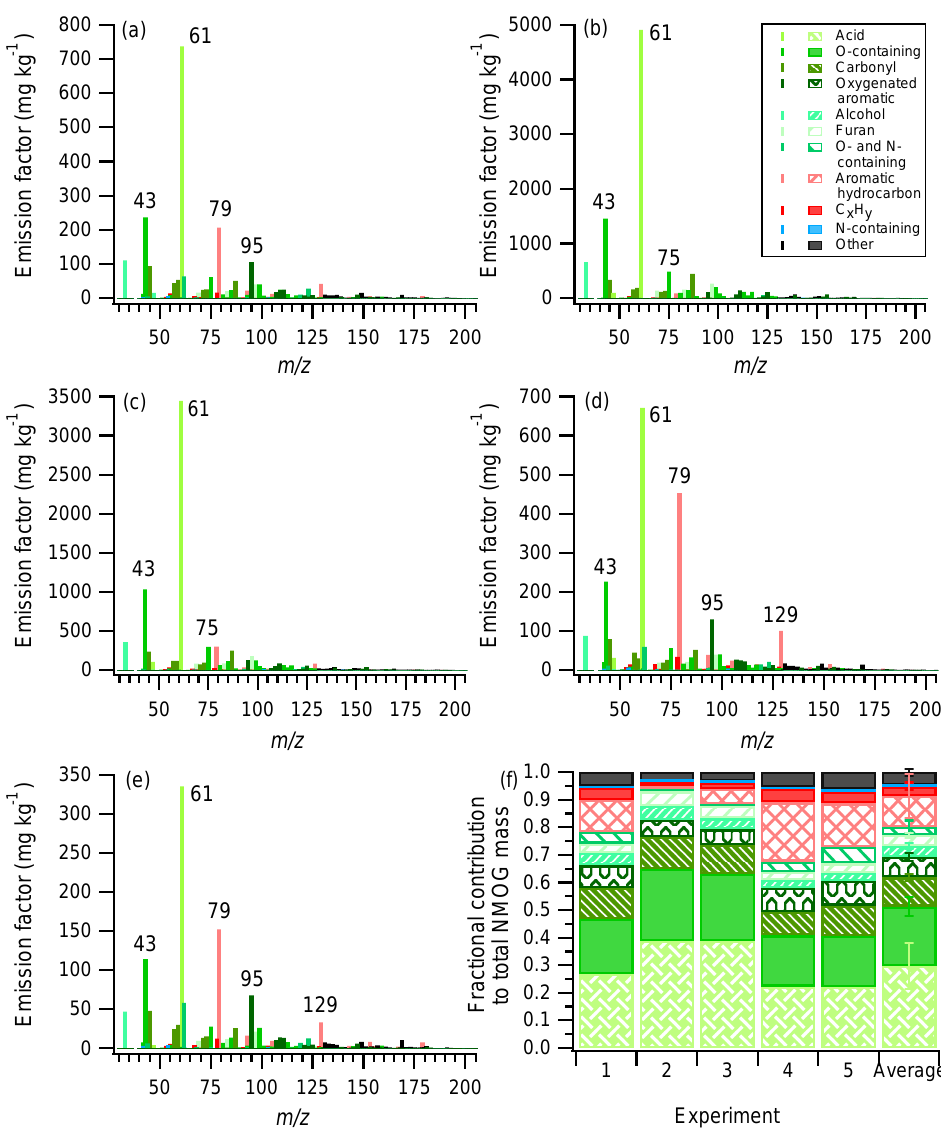
Figure 1. Mass spectra of primary NMOG emissions for experiments 1–5 ( a – e ) colored by functional group. ( a – e ) Labeled peaks correspond to [C 2 H 3 O] + ( m/z 43, fragment from higher molecular weight compounds), [C 2 H 4 O 2 + H] + ( m/z 61, acetic acid), [C 3 H 6 O 2 + H] + ( m/z 75, methyl acetate), [C 6 H 6 + H] + ( m/z 79, benzene), [C 6 H 6 O + H] + ( m/z 95, phenol) and [C 10 H 8 + H] + ( m/z 129, naphthalene). The bars in (f) correspond to the fractional contribution of each functional group to the total NMOG mass for each experiment and the average of all experiments. Error bars correspond to one sample standard deviation of the replicates. Legend in (b) applies to (a) – (f)